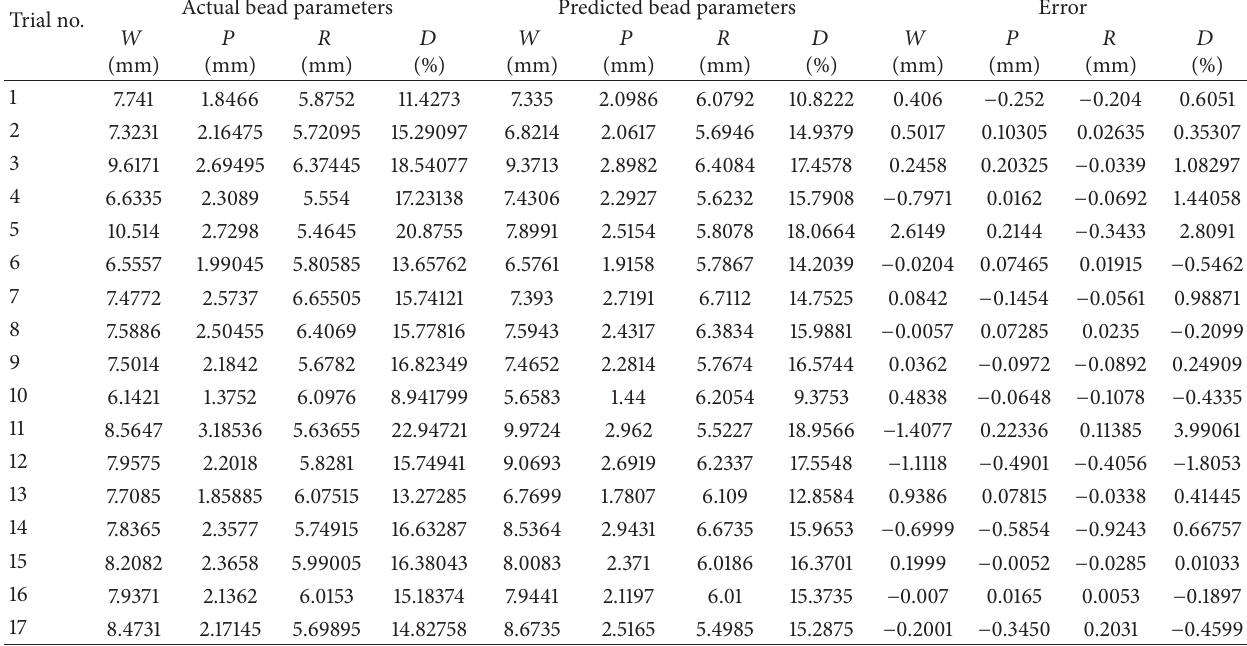
Table 7: Comparison of actual and predicted values of the clad bead parameters using neural network data (training). Trial no.